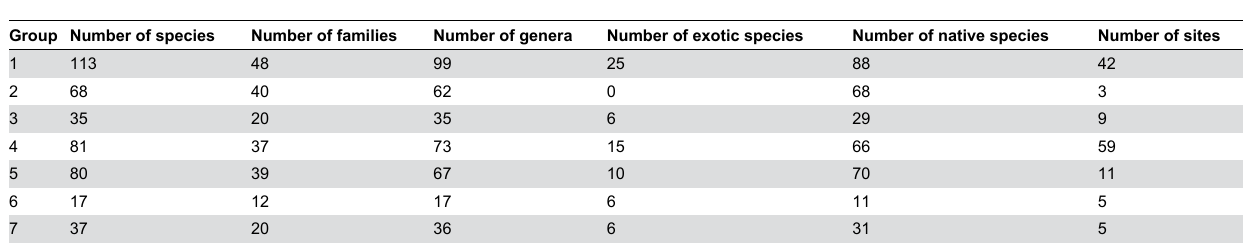
Note: The group numbers are corresponding to the 7 groups in Figure 7 from left to right sequentially.